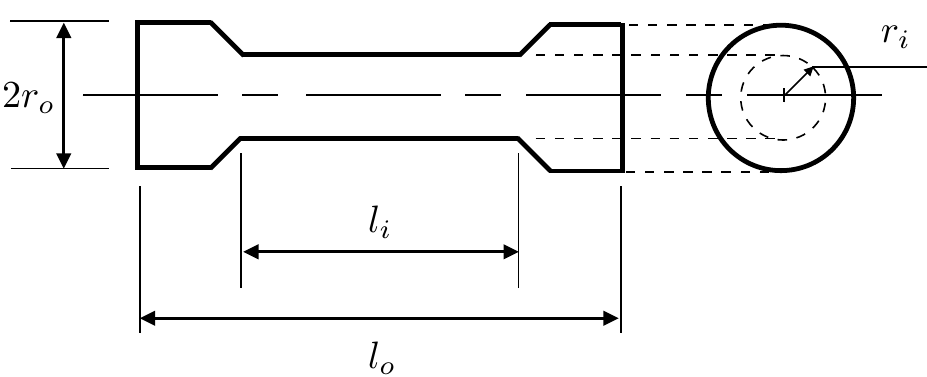
Figure 2. Schematic showing a 2D projection of a typical beam. For the reference case the inner and outer dimensions are ( l i “ 0.45 m, r i “ 0.025 m) and ( r o “ 0.05 m and, l o “ 1.0 m), respectively.